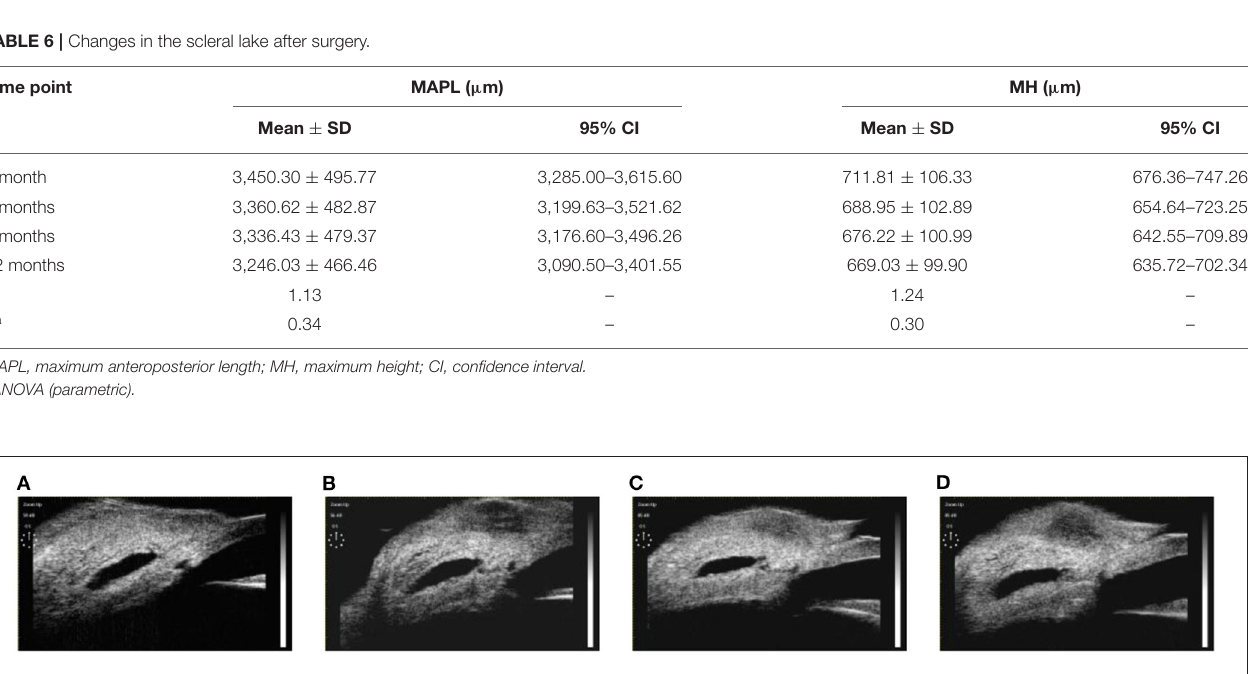
FIGURE 3 | Changes in the scleral reservoirs in ultrasound biomicroscopy (UBM) images at different time points after surgery. (A) At 1 month after surgery. (B) At 3 months after surgery. (C) At 6 months after surgery. (D) At 12 months after surgery.